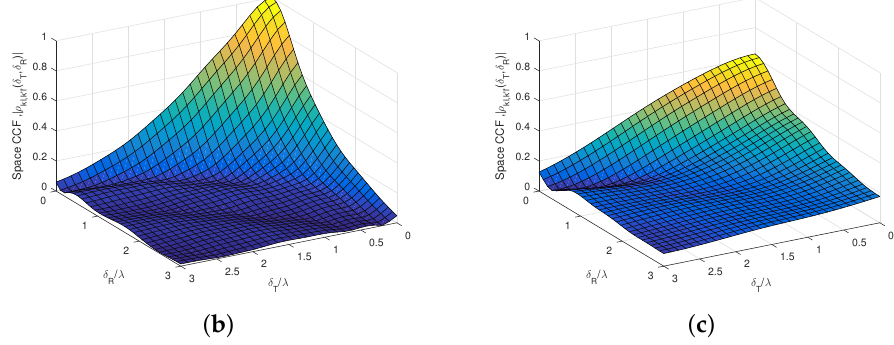
Figure 11. SCCF of SRT and without ceiling for NLoS scenario ( c R = 0 ) . ( a ) SCCF of SRT. ( b ) SCCF of SRT without ceiling.